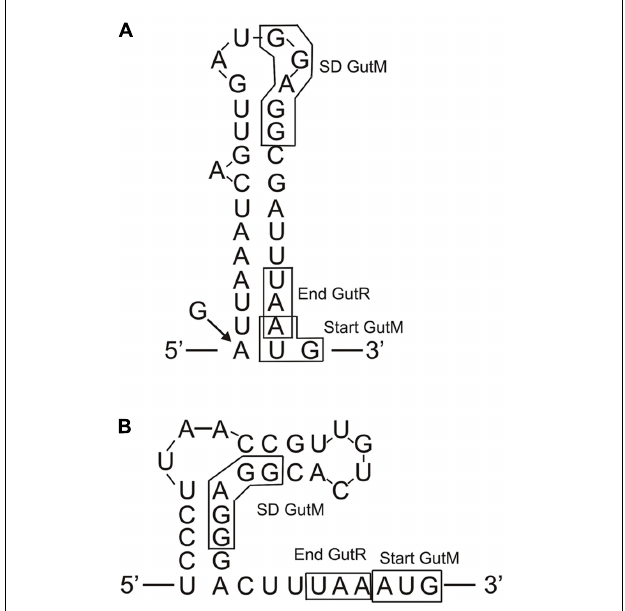
FIGURE 9 | Predicted folding of the gut mRNA region including the 3 (cid:48) -end of gutR and the 5 (cid:48) -end of gutM . (A) Secondary structure of the wild-type P. parvulus 2.6 and L. plantarum 90 gut operons. The arrow and the G indicate that in the insert of pRCR18 G substitute to the A in the indicated position. (B) Secondary structure of the L. casei BL23 gut